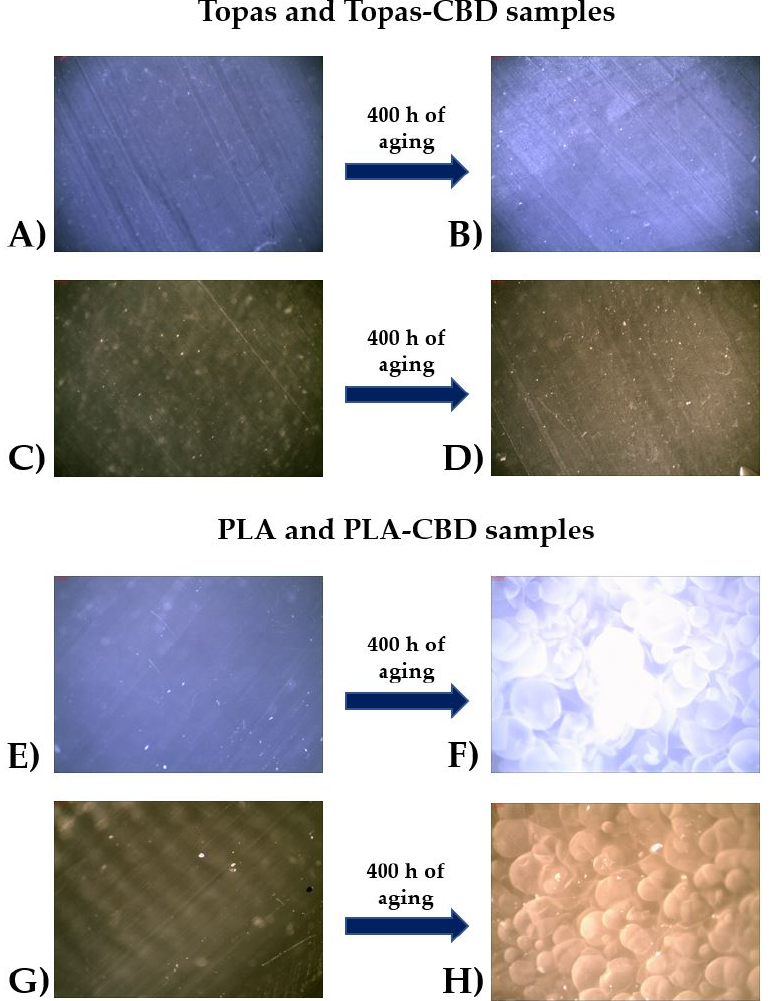
Figure 2. Morphology analysis with an optical microscope at 130 × magnification of ( A ) ethylene- norbornene copolymer (Topas) before aging, ( B ) Topas after 400 h of weathering, ( C ) Topas-CBD reference sample, ( D ) Topas-CBD after 400 h of weathering, ( E ) polylactide (PLA) before aging, ( F ) PLA after 400 h of weathering, ( G ) PLA-CBD reference sample, ( H ) PLA-CBD after 400 h of weathering, respectively.